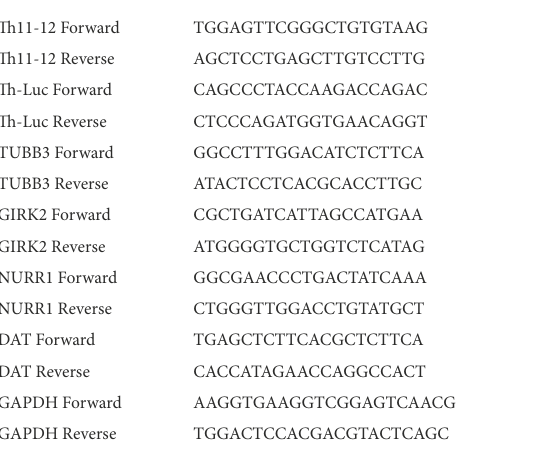
TABLE 1 Primers used in this study.